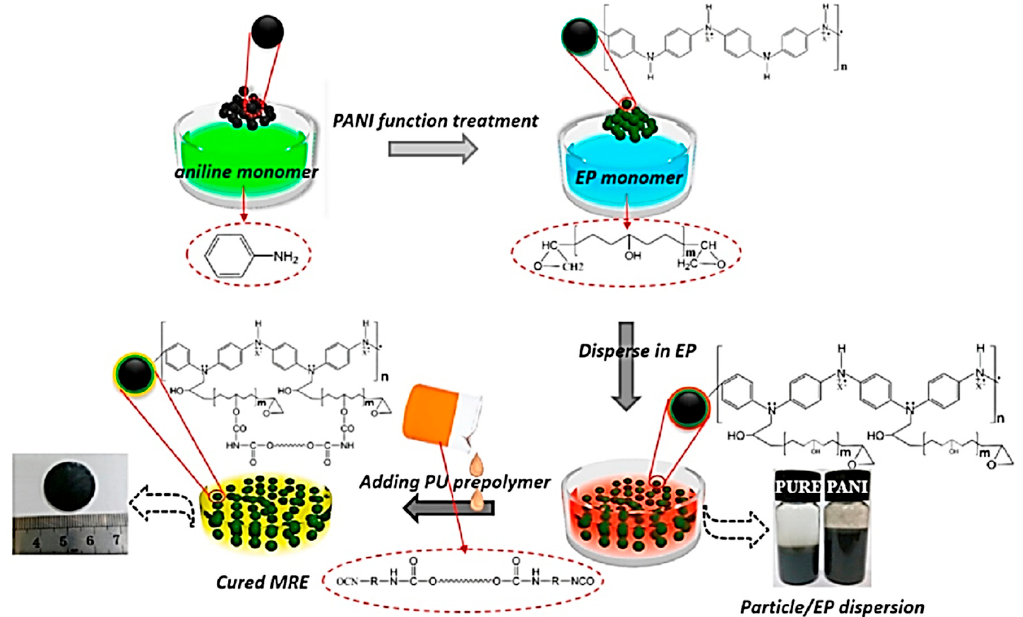
Figure 2. Schematic of surface modification mechanism of carbonyl iron particles (CIPs) with Polyaniline (PANI) coating and fabrication of PANI-modified CIP-based isotropic MREs [91] (reprinted with permission from Elsevier TM ).